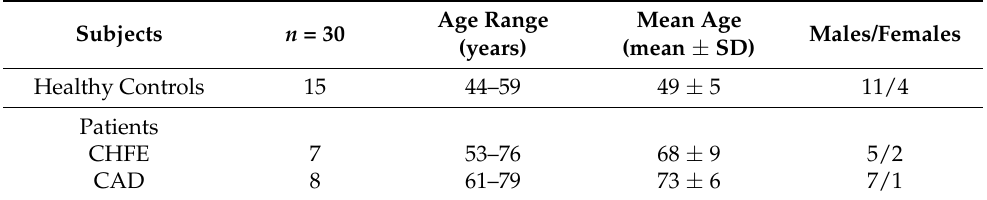
Table 4. Demographic data of participants: age range, the mean age, males/females ratio and body mass index (BMI) reported for healthy controls and in patients with chronic heart failure exacerbations (CHFE) or coronary artery disease (CAD).